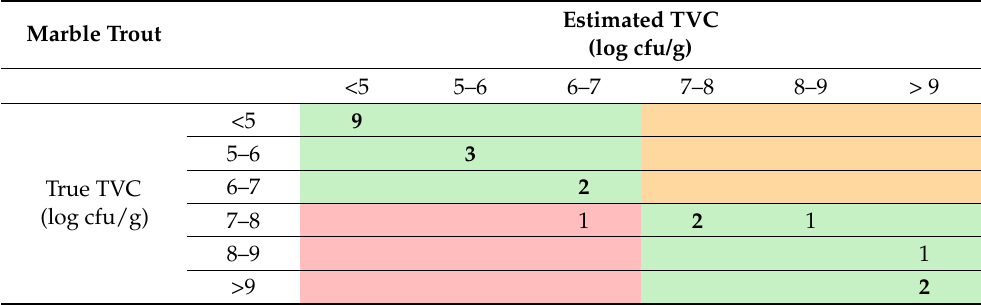
Table 3. Confusion matrix of classification regarding the state of freshness of marble trout samples. The background color represents the extent of the severity of a possible